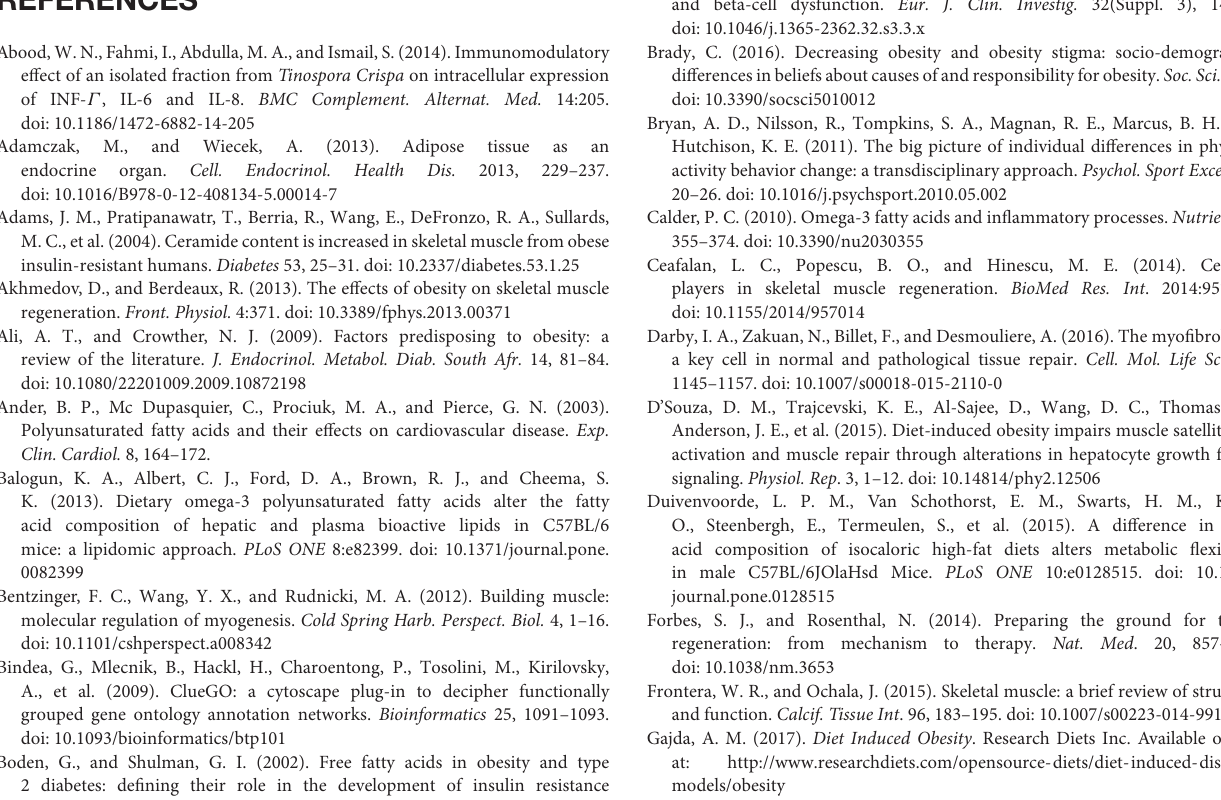
Supplement 2.4 | Significance levels of FA-composition in triglyceride fraction in muscle tissue; n = 18 per group. Statistical analysis by two-sided homoscedastic t -test. ∗ Indicates p ≤ 0.01, ∗∗ Indicates p ≤ 0.05.